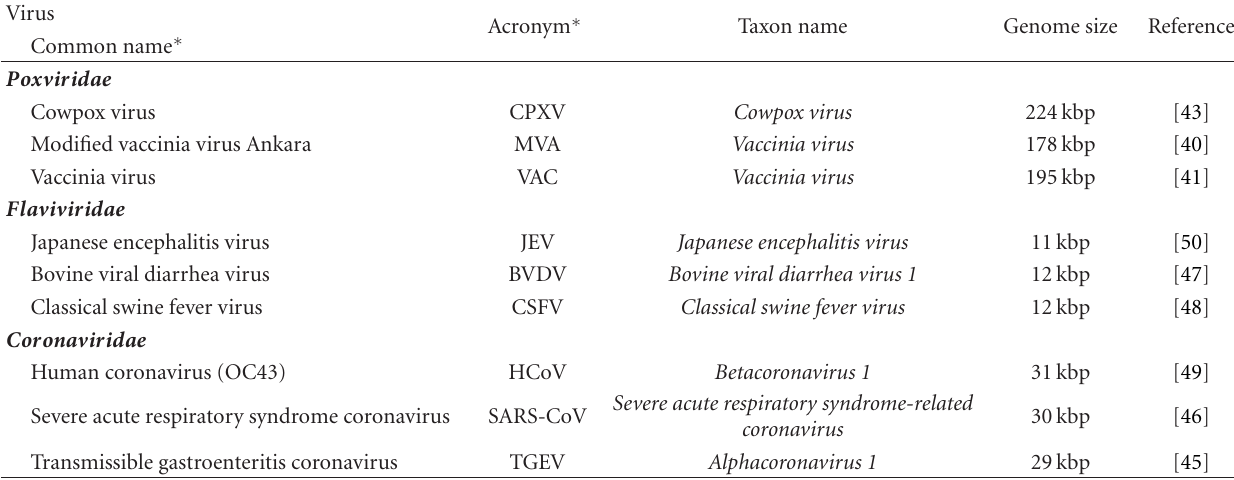
Table 2: Overview of published BAC systems for members of the Poxviridae, Flaviviridae, and Coronaviridae family. Common species names, corresponding acronyms, taxon names, genome sizes, and references for the first BAC construct of every species are